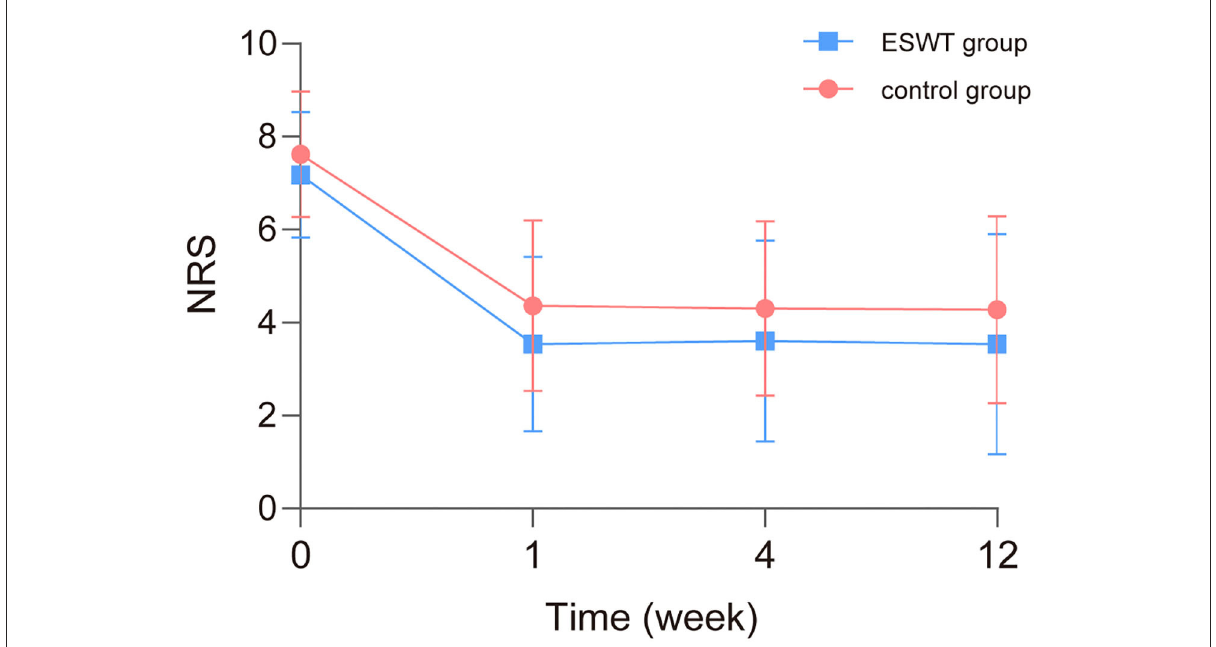
FIGURE3 Baseline and post-treatment numeric rating scale (NRS) scores. The NRS scores in the ESWT group and control group decreased over time similarly. NRS scores of the ESWT group were statistically lower than the control